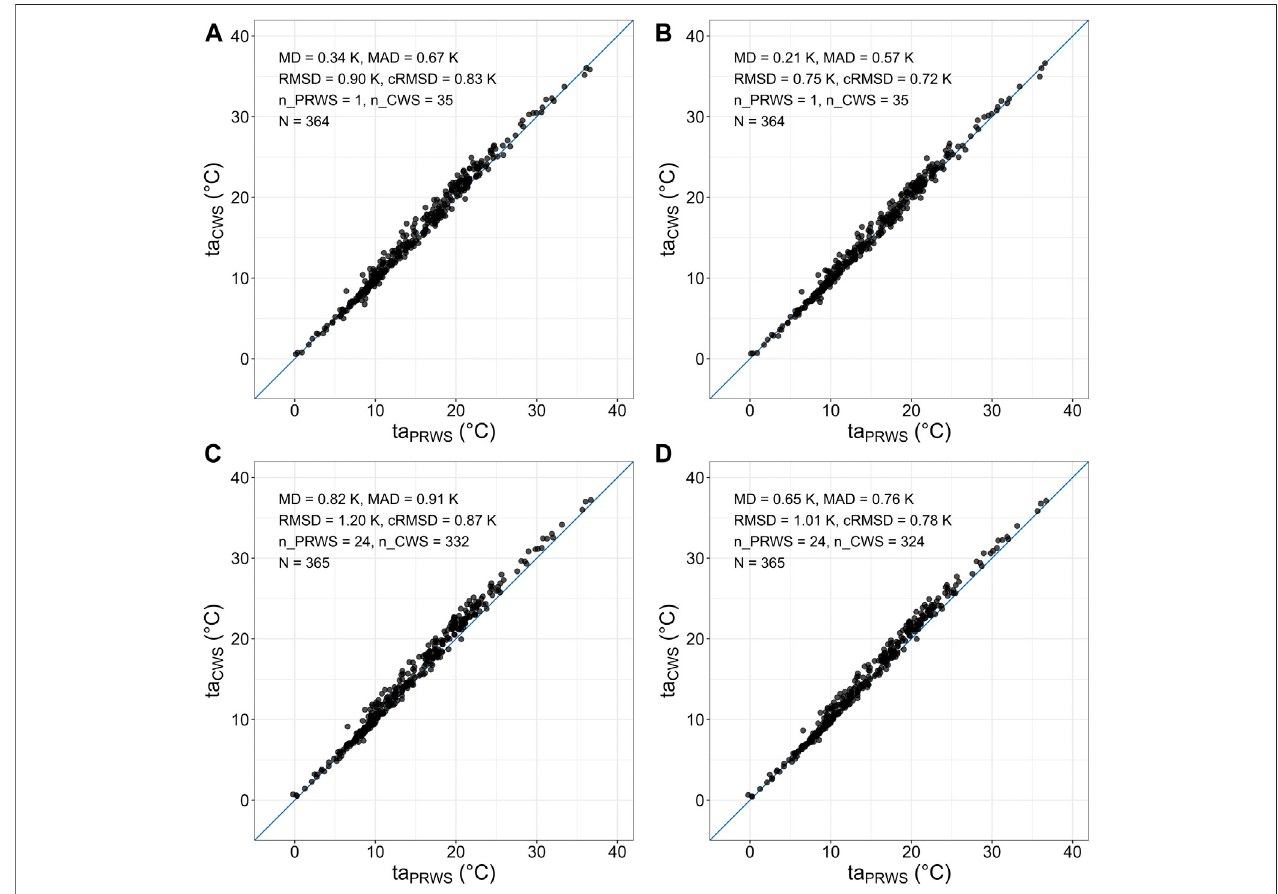
FIGURE 7 | Relation between daily maximum air temperature ( ta ) at PRWS and CWS in Amsterdam during 2019. (A) and (B) for one PRWS (station “ 2229 ” ; 52.3719 ° N,4.89568 ° E)andthemeanofallCWSwithina2000 mradiusaroundthePRWSinthesameLCZtype(2 – compactmidrise). (C) and (D) asthemeanacrossall PRWS and all CWS. (A) and (C) display CWS ta at QC level m4, (B) and (D) CWS ta at QC level m5. MD, mean deviation; MAD, mean absolute deviation; RMSD, root- mean-square deviation; cRMSD, centred RMSD; n_PRWS, number of PRWS; n_CWS, number of CWS; N, number of daily values.